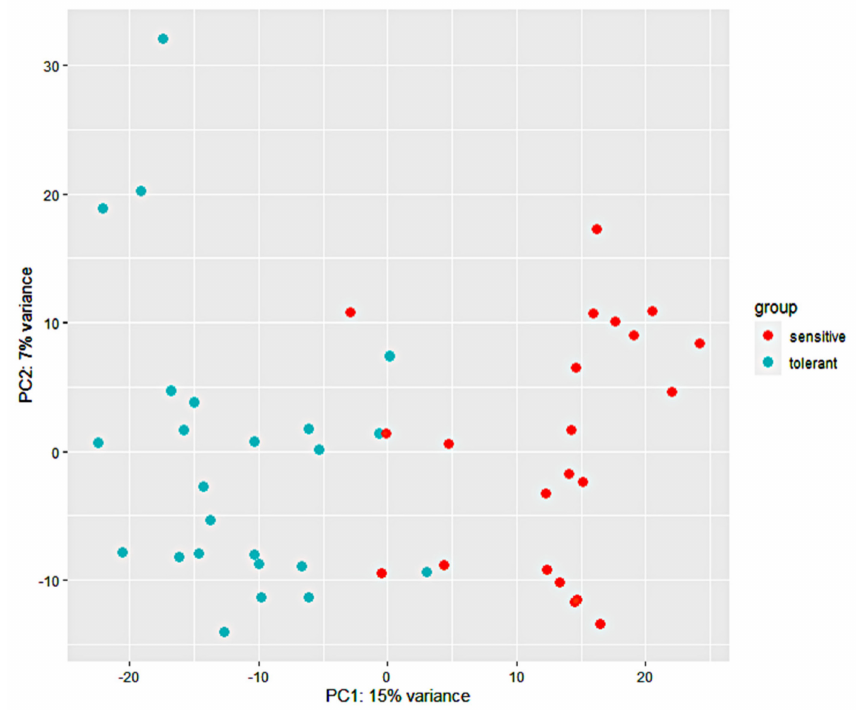
Figure 2. Principal component analysis (PCA) of pairwise genetic distance. The grouping of the 46 maize inbred line populations is indicated using blue (tolerant) and orange (sensitive). The proportion of variance captured is given as a percentage for both the first and second prin- cipal components (PC1 and PC2).